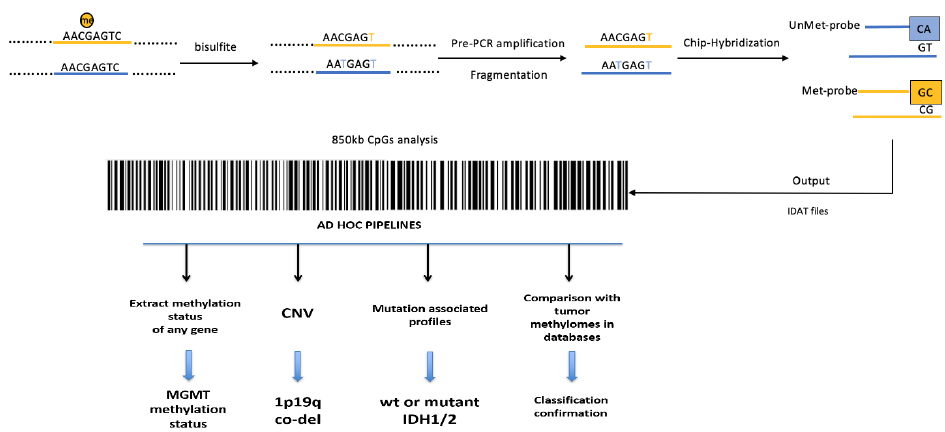
Figure 3. Methylome workflow and data analysis: schematic representation of the analytic steps to perform the EPIC array. DNA is converted with sodium bisulfite, pre-amplificated and fragmented. DNA is, then, hybridized on a specific array with specific probes recognizing the single CG both if methylated or if not methylated. The technology analyzes 850,000 CpG sites tracing a sort of tumor barcode. Output raw data are analyzed using different bioinformatic pipelines to extrapolate information useful for the characterization of the tumor, such as the methylation status of the MGMT gene, the copy number variations (CNVs), the co-deletion 1p-19q, the presence of functional mutations in the Isocitrate Dehydrogenase (IDH) 1 and 2 genes. Using a specific comparison algorithm, the analyzed methylomic profile is compared with others present in the database for a more precise classification of the tumor.